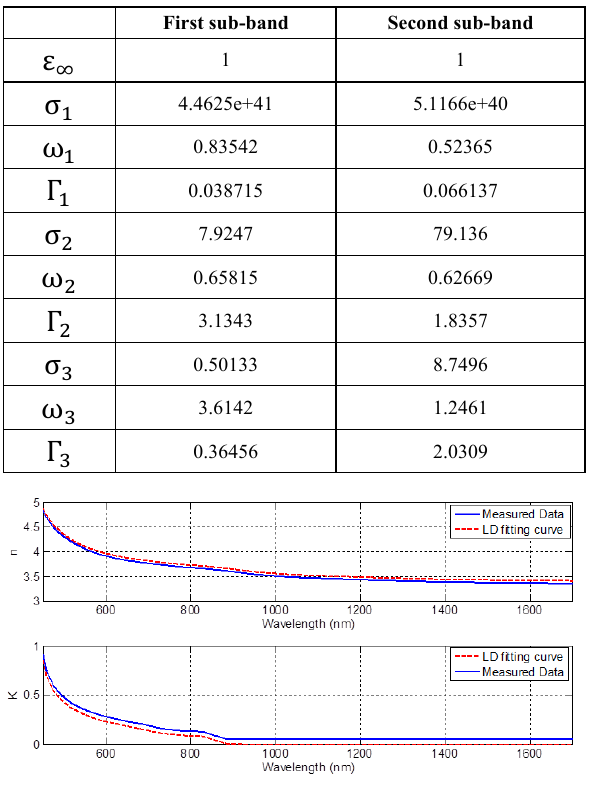
Figure 14. Experimental [12] and fitted Lorentz-Drude model for the real and imaginary parts of the GaAs refractive index in the third sub- band.